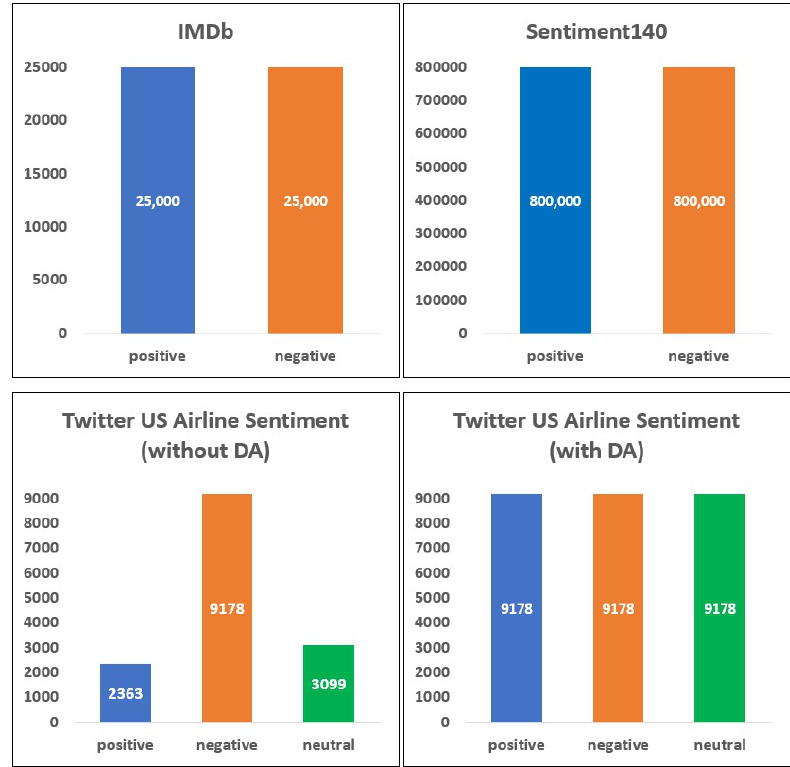
Figure 3. The sample distributions of the